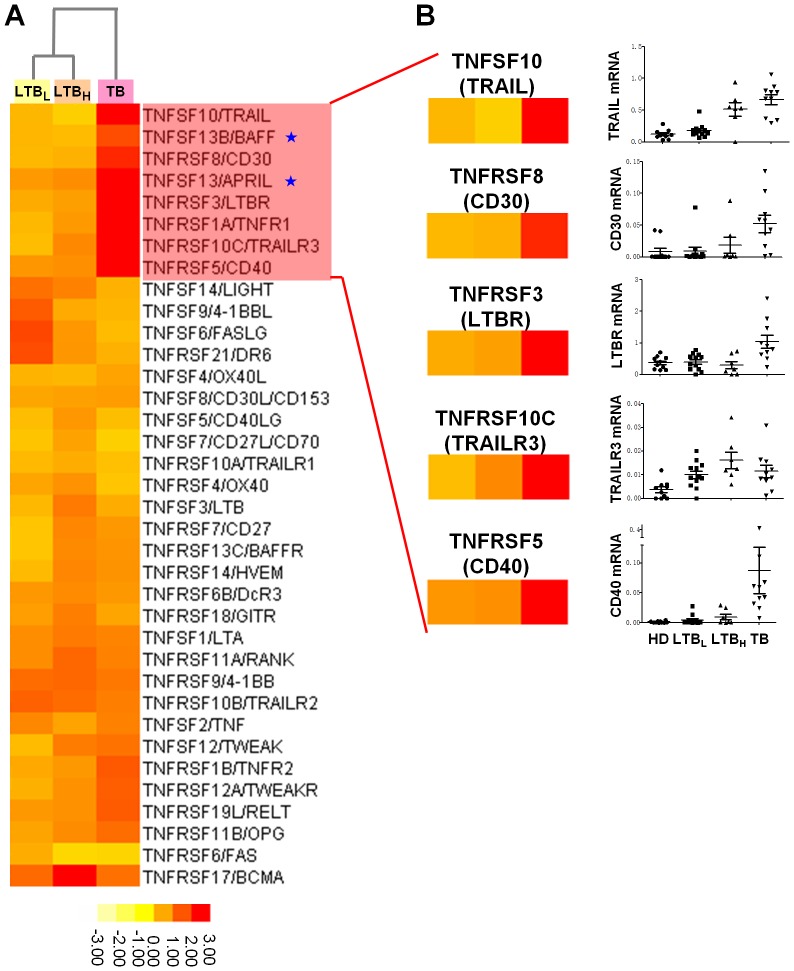
Validation of genes related to the TNF (TNF) and TNF receptor (TNFR) superfamilies (SF).
A. Compared with the HD group, the expression levels of the genes related to the TNFSF and TNFRSF in the LTBL, LTBH and TB groups were analyzed using a clustering algorithm. Eight genes (TRAIL, BAFF, CD30, APRIL, LTBR, TNFR1, TRAILR3 and CD40) were clustered as an identical category characterized by TB specific up-regulation. B. Using real-time PCR, we validated the eight TB-specific genes and detected seven genes that were significantly increased in the peripheral CD4+ T cells of TB patients. The mRNA values of the validated genes were normalized to the housekeeping gene β-actin. The numbers of participants included in validation test were the following: HD, n = 10; LTBL, n = 12; LTBH, n = 7; TB, n = 10. The validation results among the seven genes of the pentagram are marked BAFF and APRIL in Figure 3.A.